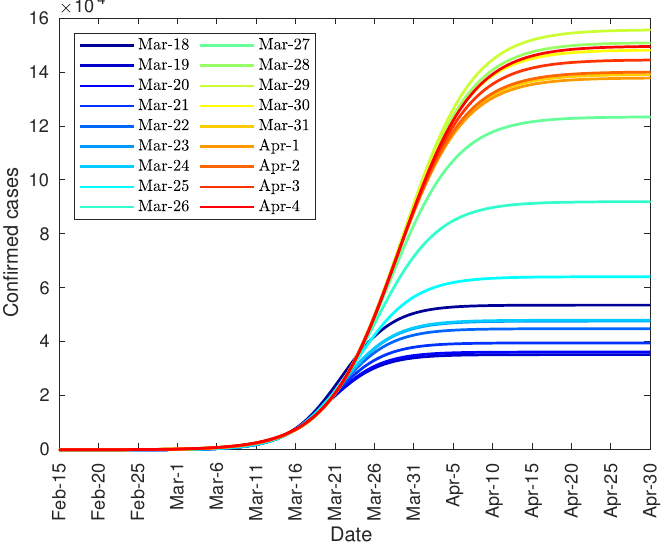
Figure 11. Evolution of the total number of diagnosed COVID-19 patients in